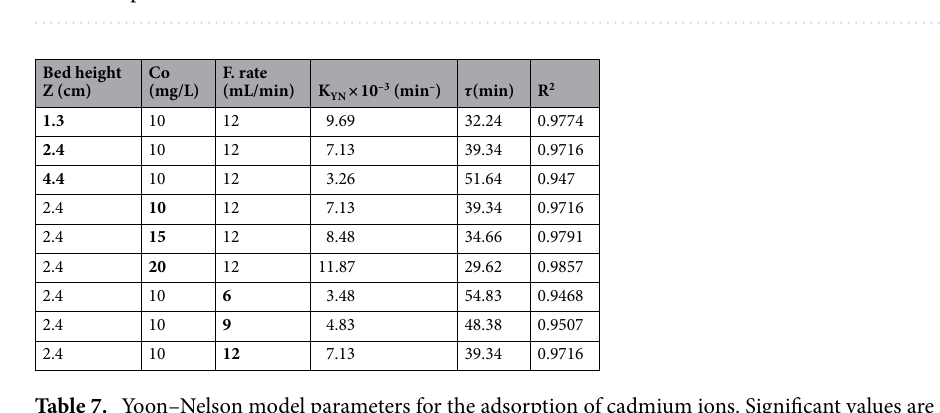
Table 7. Yoon–Nelson model parameters for the adsorption of cadmium ions. Significant values are in bold.